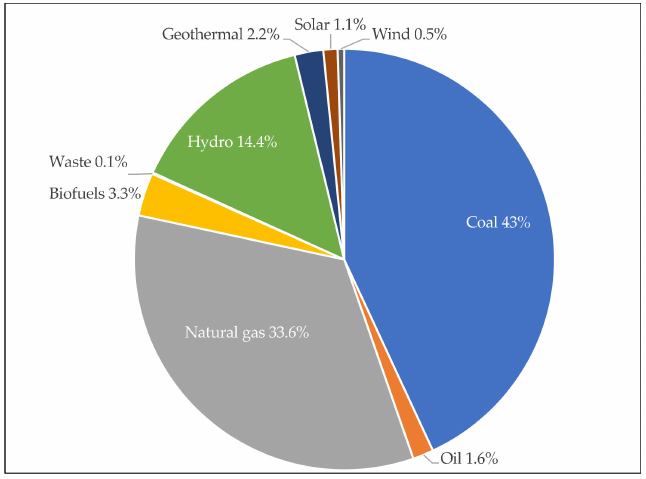
Figure 1. ASEAN electricity generation mix in 2019. Note that numbers might not add up to 100% due to rounding. Source: International Energy